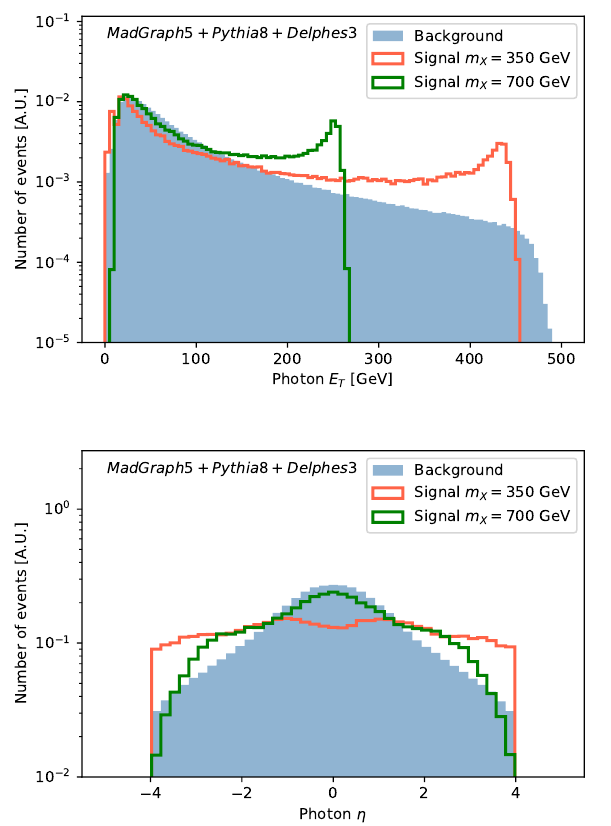
Figure 3. Distributions at detector-level of the photon transverse energy and pseudo-rapidity for the background and two signal processes. A minimum cut of 200 GeV is placed on the truth